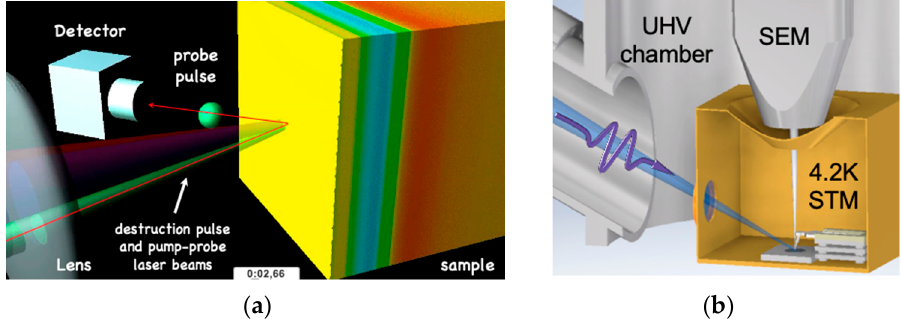
Figure 1. ( a ) A schematic picture of the domain structure that forms as a result of inhomogeneous excitation by the laser, as investigated by the 3-pulse technique. ( b ) A schematic of single-shot experiments within an STM chamber. An SEM microscope is used to align the tips and the beams on the sample.